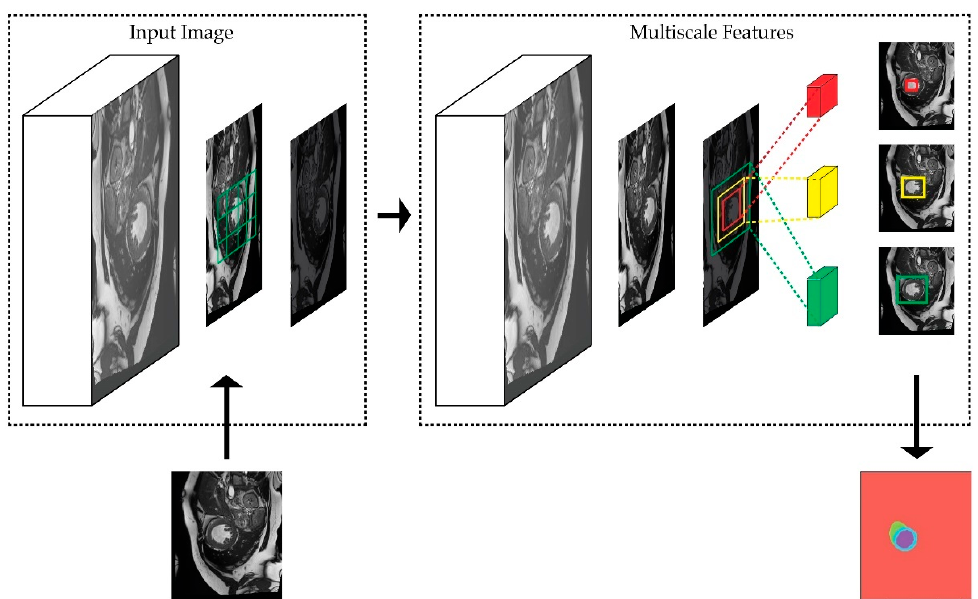
Figure 2. Multiscale receptive fields of deep-feature maps that are used to activate the visual semantics and their contexts. Multiscale representations help in better segmenting the objects by combining low-level and high-level representations.